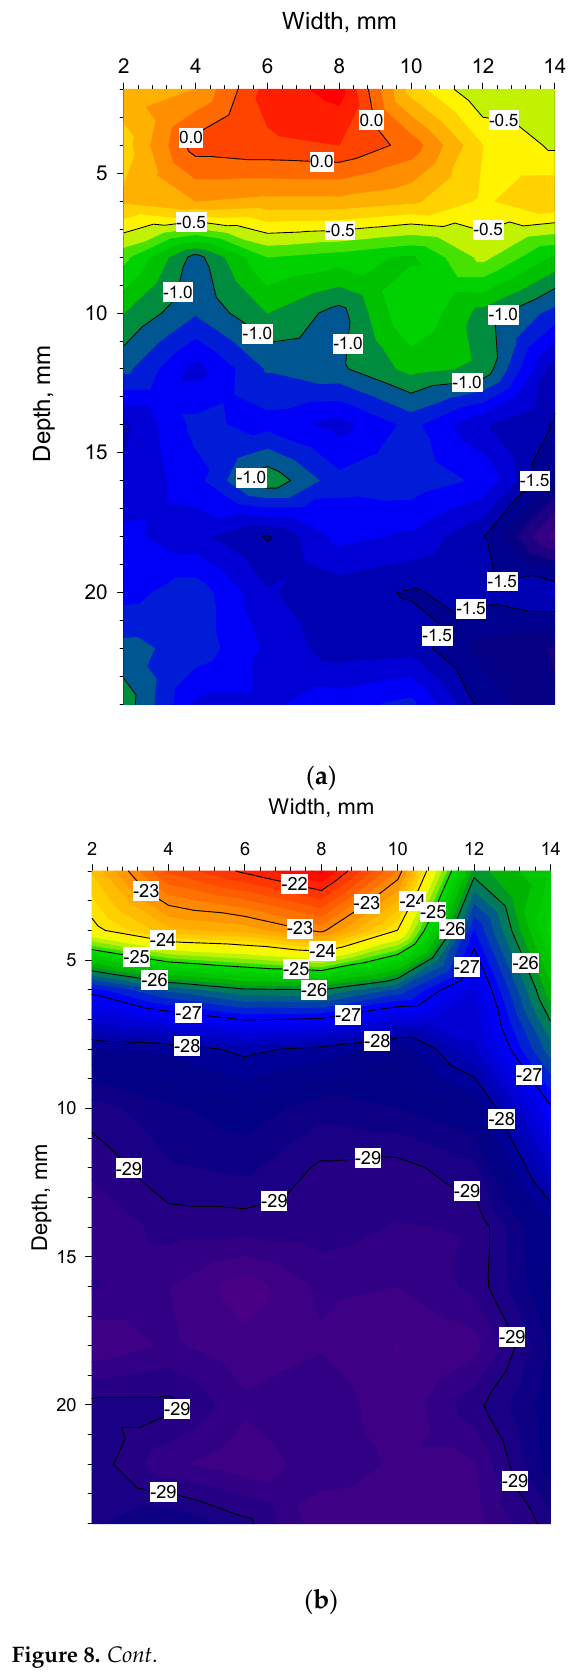
Figure 4b from 32 to 42 h, (secondary drying). Arrows show positions at 38 h and 41.7 h of spatial contour plot of the cuvette side as shown in Figure 8h and 8i, respectively. Pressure was 0.05 mbar from 32 to 36 h and 3 μ bar from 36 to 42 h.